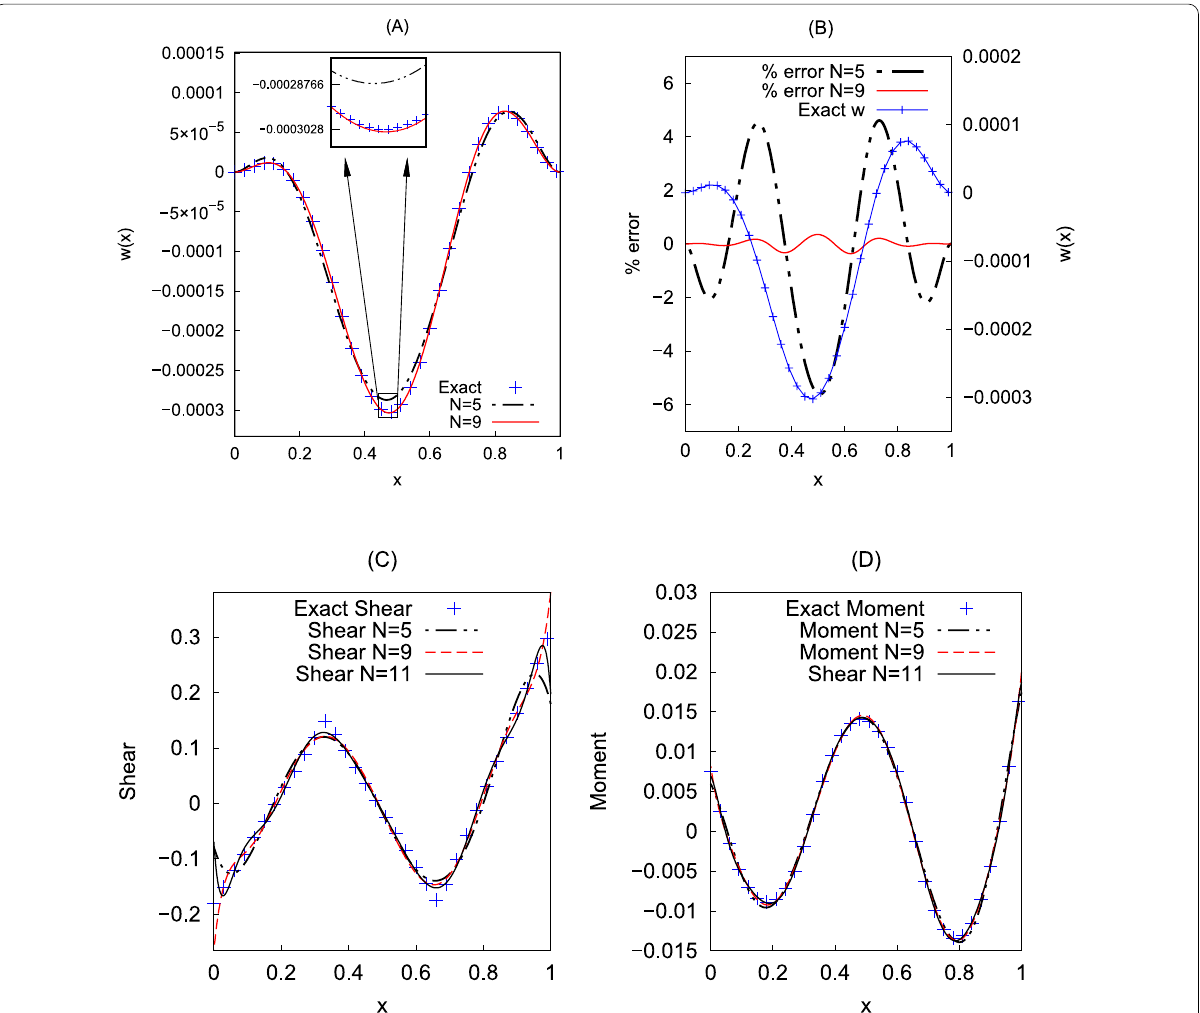
Fig. 9 Case (3) RRM and exact results. A Exact solution and RRM deflection. B Exact deflection and percentage error for various orders. C Exact and RRM shear. D Exact and RRM